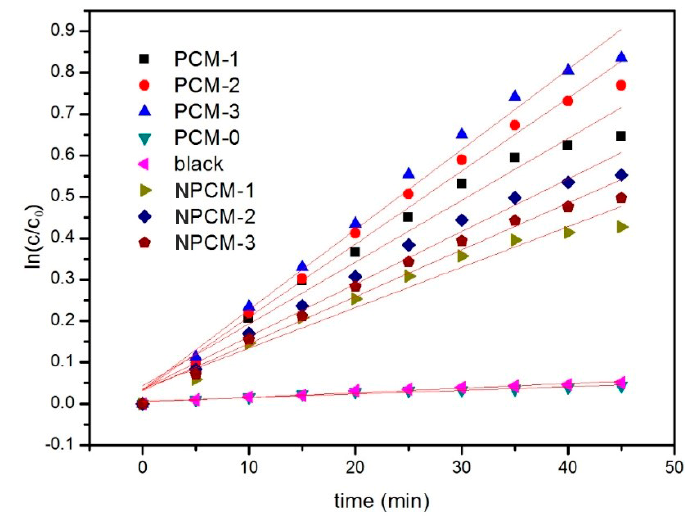
Figure 10. Photocatalytic reaction rates of acetone using different samples.